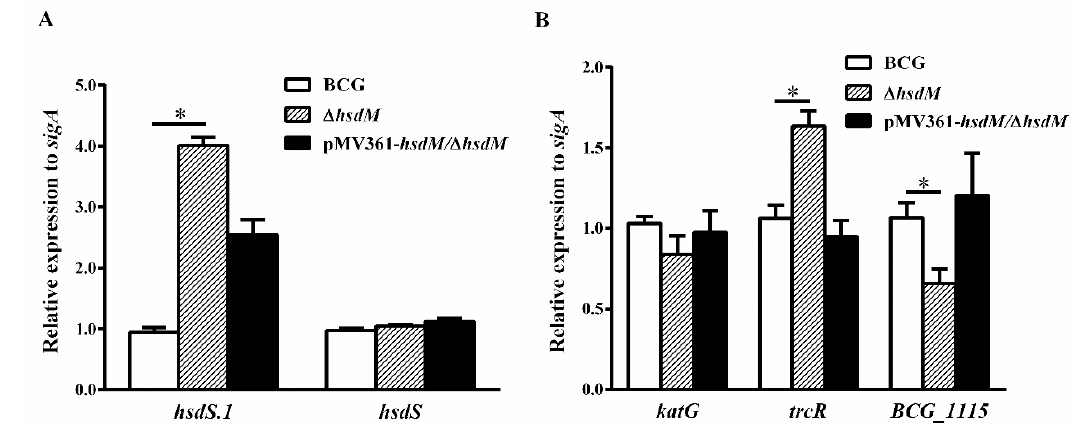
Figure 4. Genes differentially expressed in ∆ hsdM . Expression of each gene was determined by qPCR in the ∆ hsdM strain and its parental strain. ( A ) Relative expressions of hsdS and hsdS.1. * p < 0.05. ( B ) qPCR analysis of the mRNA expression of katG, trcR and BCG_1115 .